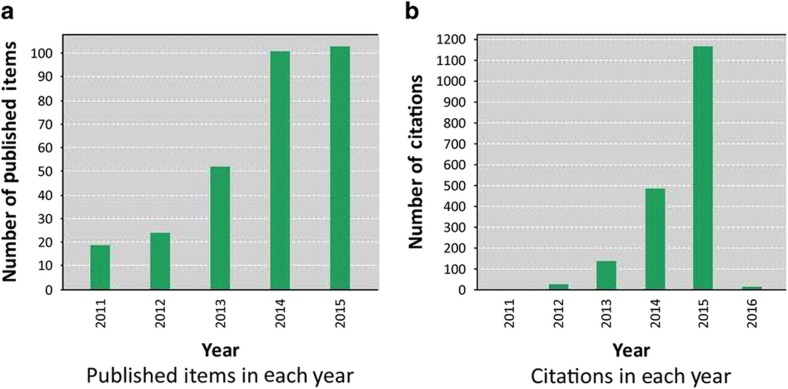
Total number of publications and citations on the topic ‘Flexible and Wearable Sensors’ in the last 5 years. Total number of (a) publications and (b) citations on the topic of ‘Flexible and Wearable Sensors’ showing a progressive increasing trend from 2011 to 2015. Source: Web of Science, January 2016.